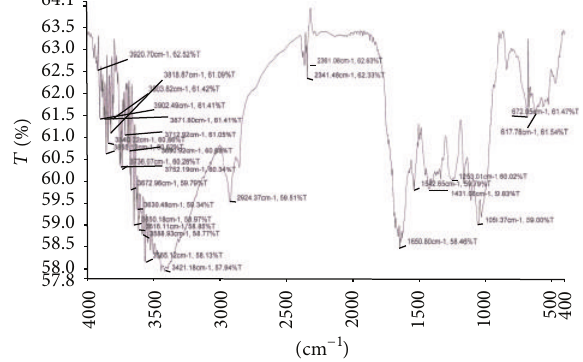
Figure 10: FTIR spectra of − PO 4 (AP) treated biomass showing different functional groups. The “ 𝑥 ” axis of the spectra denotes wavenumber (cm −1 ) and “ 𝑦 ” axis denotes transmittance (% 𝑇